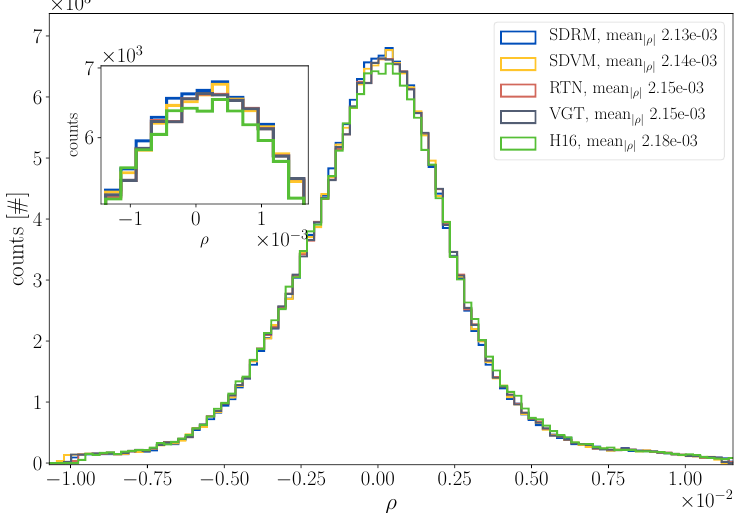
Figure 2. Histogram of the spectral residuals in orbit 8663 for SEOM and